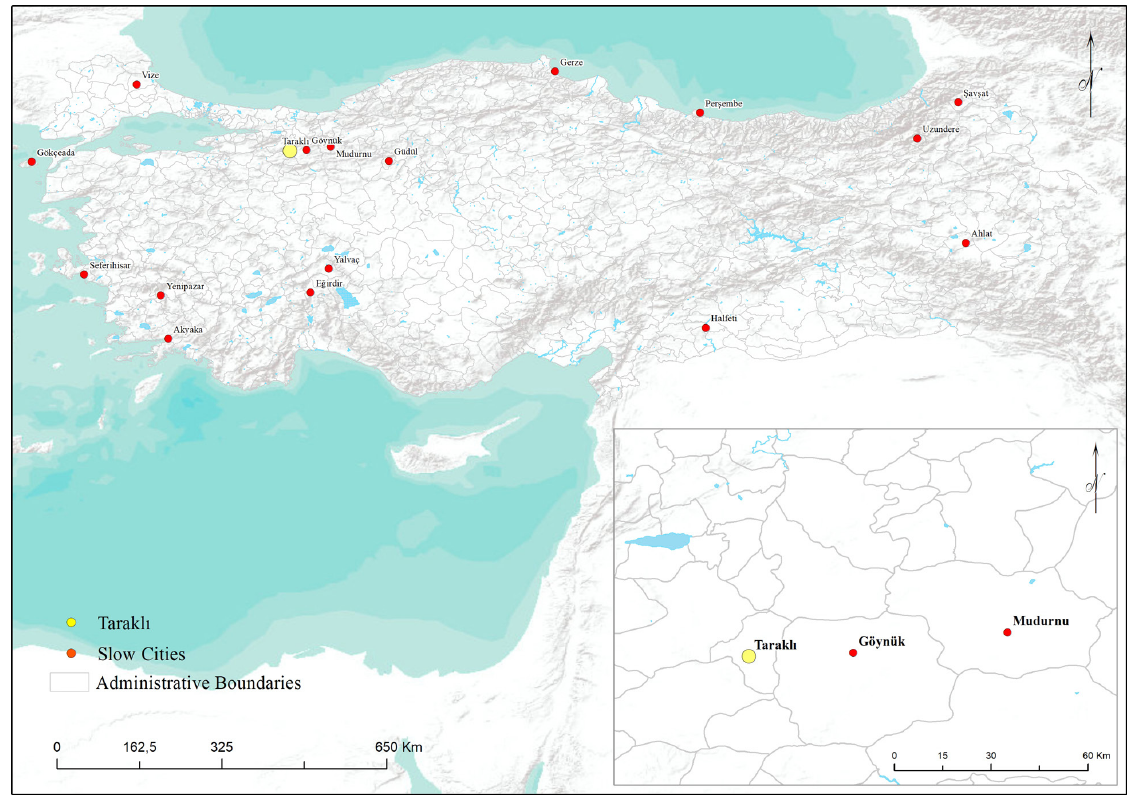
Fig. 1. location of study